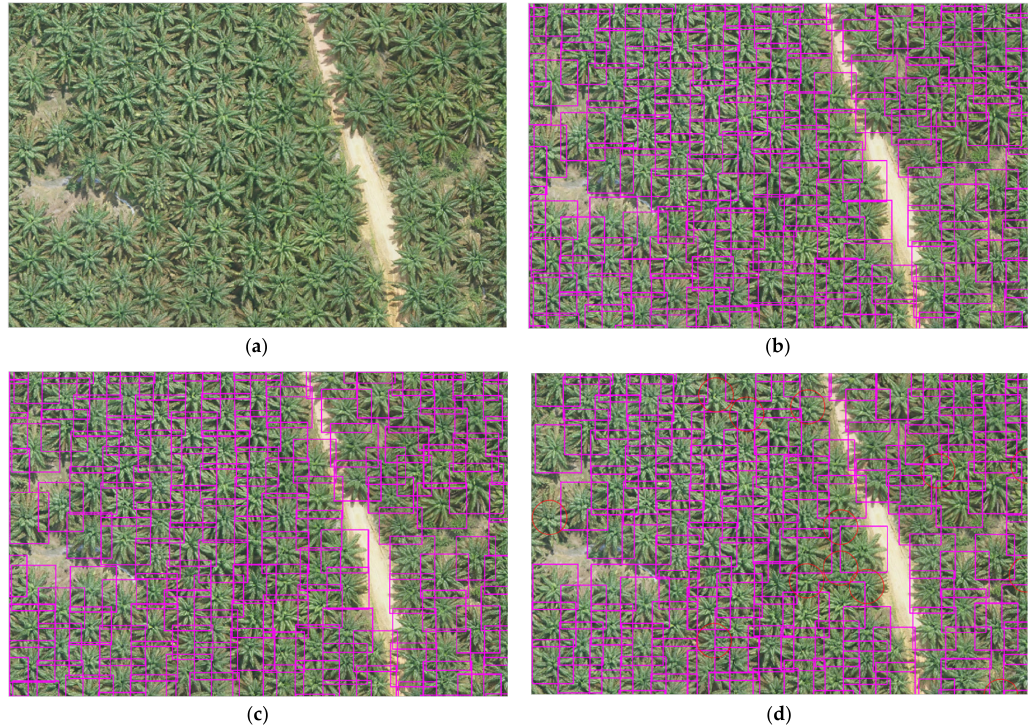
Figure 15. The dense canopy condition of the oil palm trees: ( a ) Original image; ( b ) YOLOv3 detection; ( c ) YOLOv4 detection; ( d ) YOLOv5m detection.